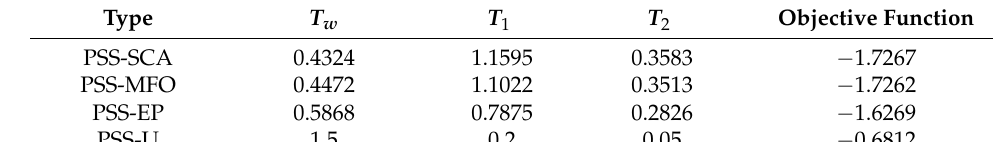
Table 4. Comparison of PSS-SCA, PSS-MFO, PSS-EP, and PSS-U for case 2.